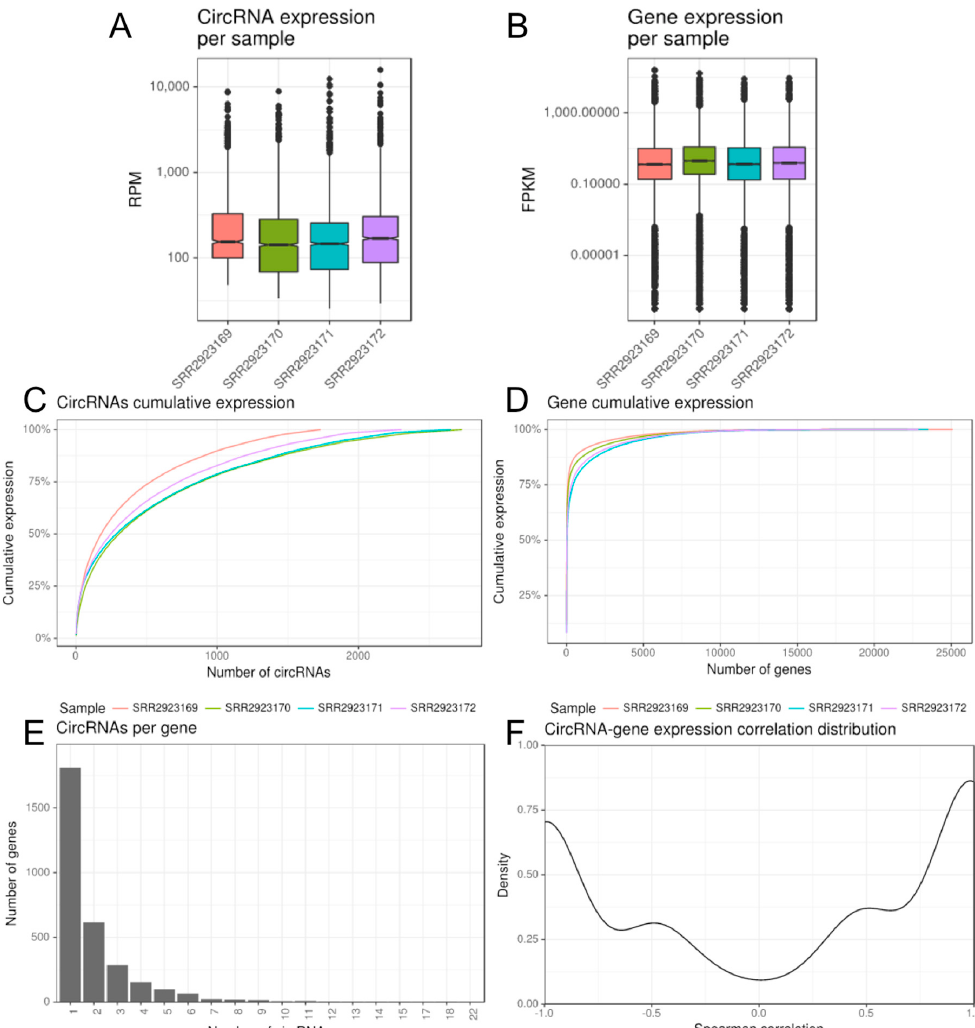
Figure 2. CirComPara summary plots of circRNA and gene expression and integration thereof. ( A , B ) twin boxplots of circRNA and gene expression levels per sample; ( C , D ) cumulative expression plots of circRNA and gene per sample; ( E ) frequency distribution of number of circRNAs per gene; ( F ) density distribution of pairwise circRNA/gene Spearman correlation values.